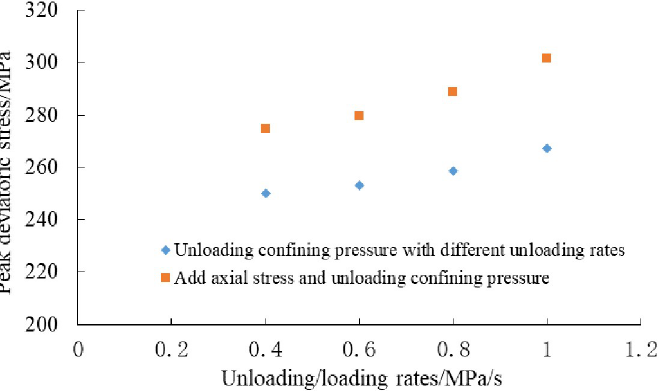
Fig 3. The relationship between peak deviatoric stress and different unloading